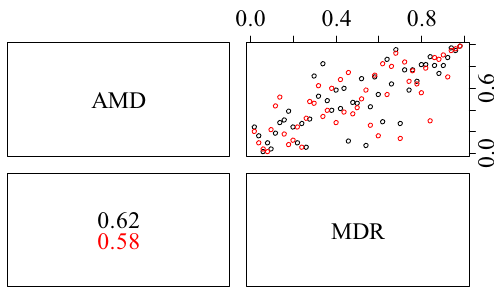
Fig. 7 Results of simulation and observation series of AMD and MDR with their Kendall’s